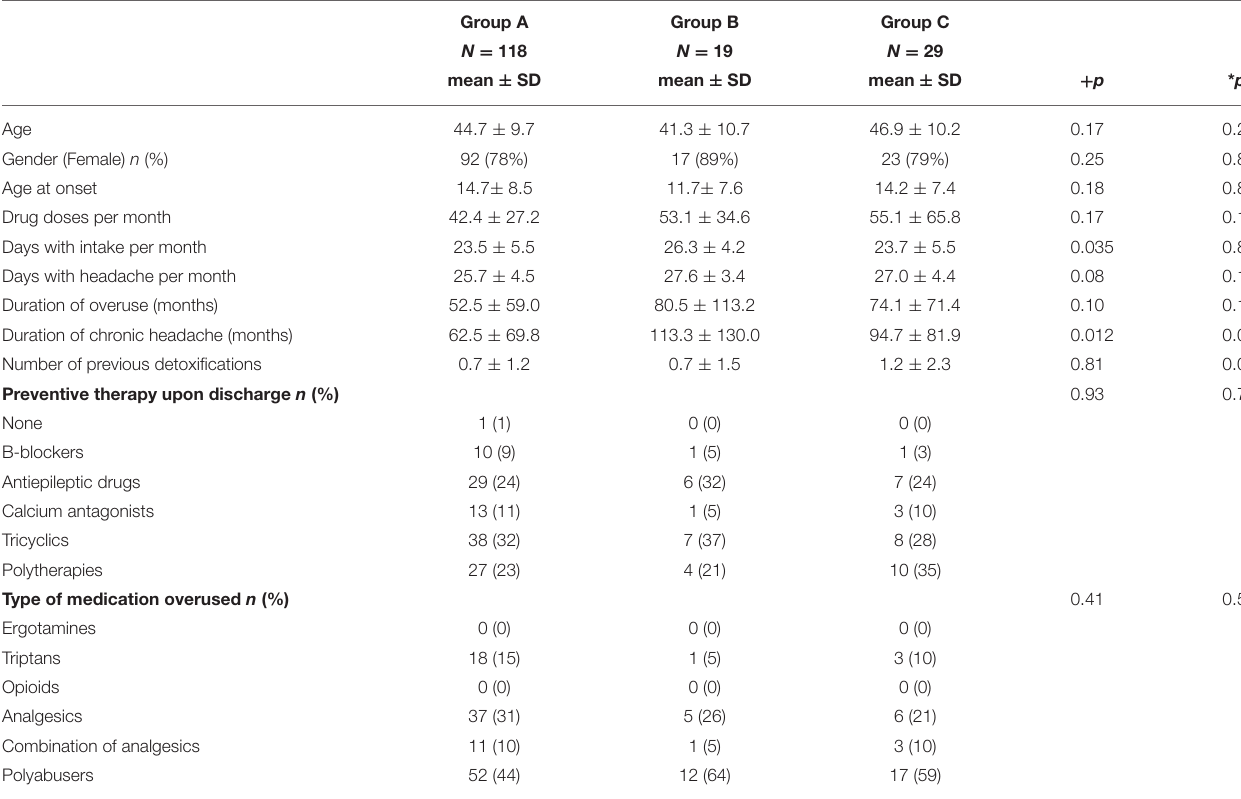
TABLE 1 | Demographic and clinical characteristics of the three groups at